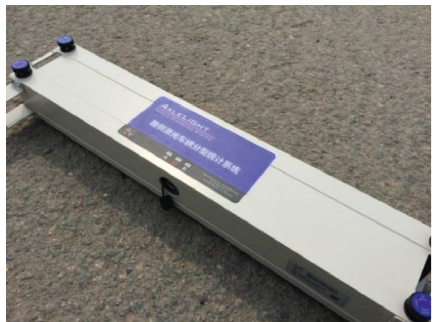
Figure 3: Vehicle classification statistical